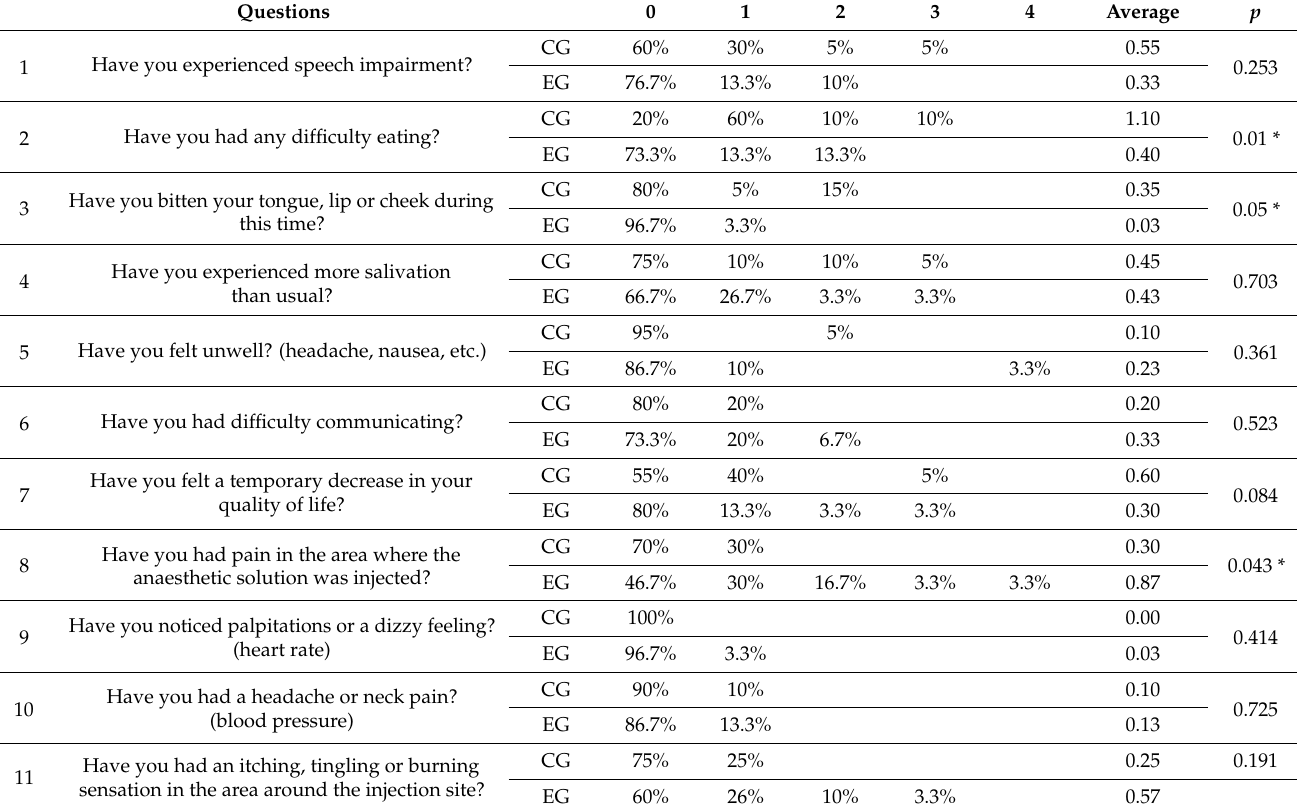
Figure 4. Percentage of patients who used analgesics. An analysis of the postoperative clinical questionnaire collected at 24 h (Table 2) showed statistically significant differences in relation to difficulty in chewing ( p = 0.01) and accidental bites ( p = 0.05), which were greater in CG. On the contrary, greater pain in the anaesthetic area was recorded in EG ( p = 0.043). Regarding possible adverse effects of OraVerse ® , no statistically significant values Table 2. Clinical aspects and adverse effects collected during first 24 h were observed between the two groups. Speech impairment ( p = 0.633), nausea ( p = 0.402), feeling of palpitation or dizziness ( p = 0.31) and head or neck pain ( p = 0.393) did not differ between the two groups.